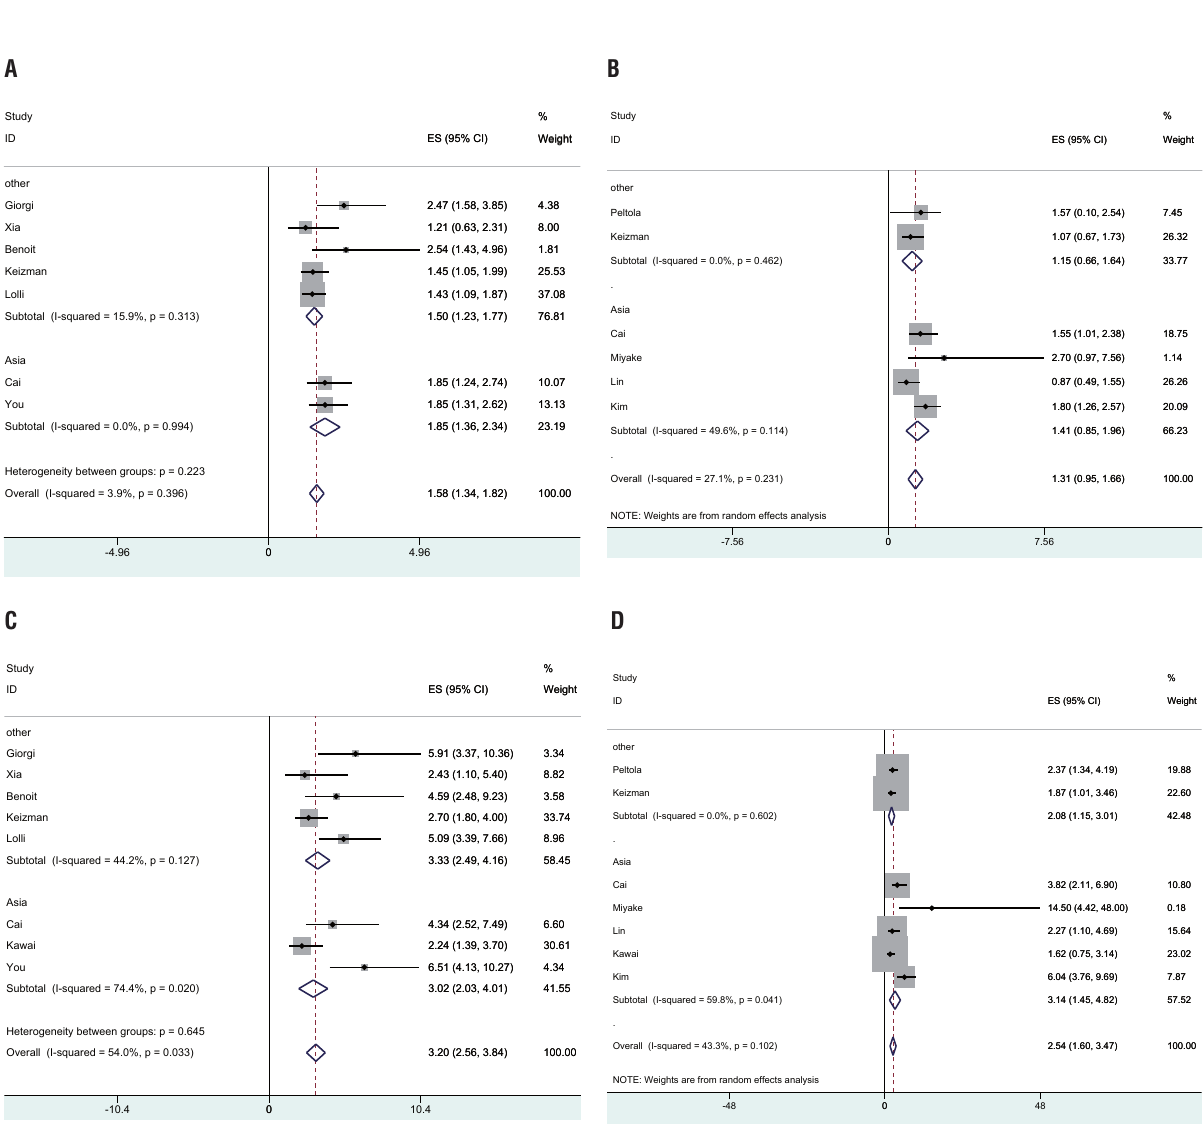
Supplementary Figure 1 - Subgroup analysis of area for